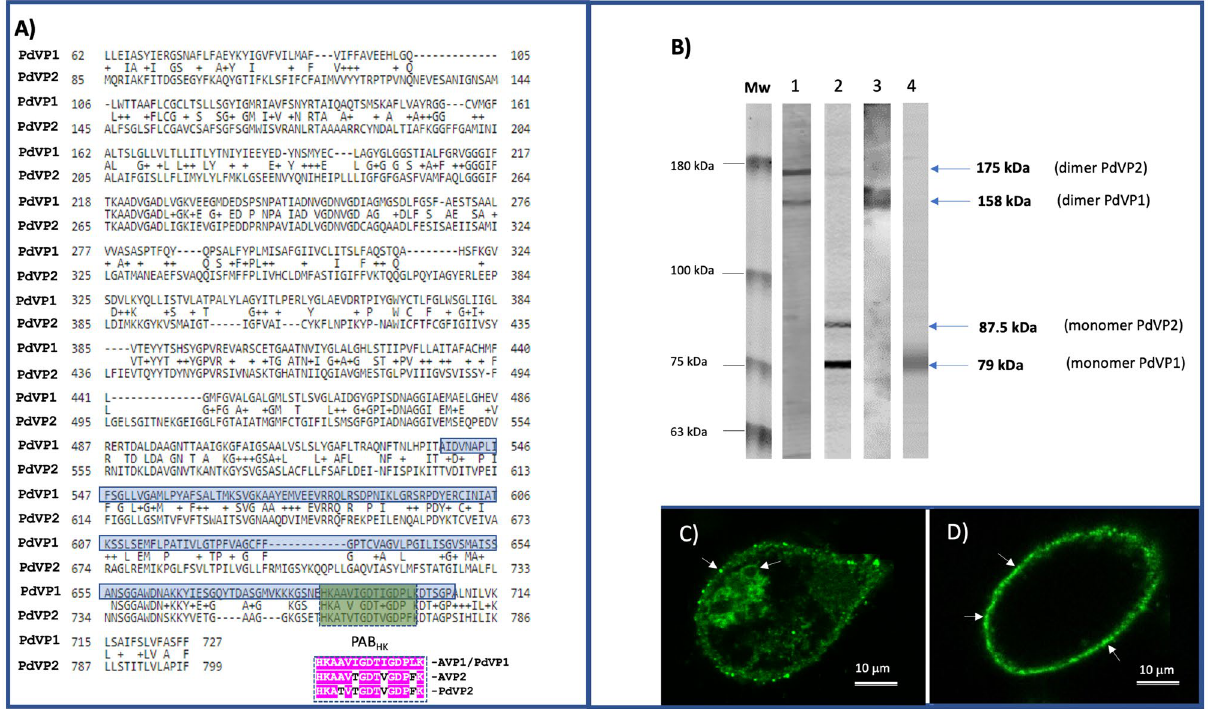
Figure 4. ( A ) Alignments of the aa sequences of the PdVP1 and PdVP2 isoenzymes of H + -PPases of P. dicentrarchi using the Blastp program (https:// blast. ncbi. nlm. nih. gov/ Blast. cgi). The blue shaded sequence corresponds to the fragment of the aa sequence of the PdVP1 isoenzyme expressed as a recombinant protein in the yeast Klyuveromyces lactis (rPdVP1), and the green shaded sequence corresponds to the HKAAVIGDTIGDPLK (HK) peptide of the isoenzyme PdVP1. The alignments of the PAB HK motif in the V-H + - PPases AVP1 and AVP2 of Arabidopsis thaliana and the V-H + -PPases PdVP1 and PdVP2 of P. dicentrarchi , shown in pink shading, represent the common regions. ( B ) Western blot analysis of components of a P. dicentrarchi ciliate lysate (CL) separated by SDS-PAGE under non-reducing (-DTT; lanes 1 and 3) and reducing (+ DTT; lanes 2 and 4) conditions in the presence of polyclonal mouse antibodies α-rPdVP1 (lanes 1 and 2) and α-KLH-HK (lanes 3 and 4). Mw: molecular weight markers in kDa. ( C , D ) Immunolocalization of H + -PPases